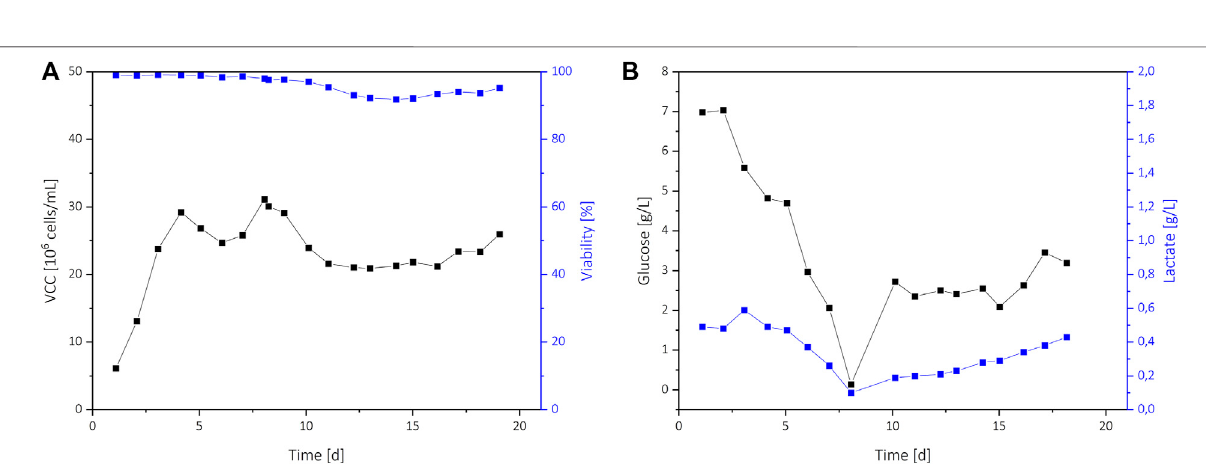
Frontiers in Bioengineering and Biotechnology |